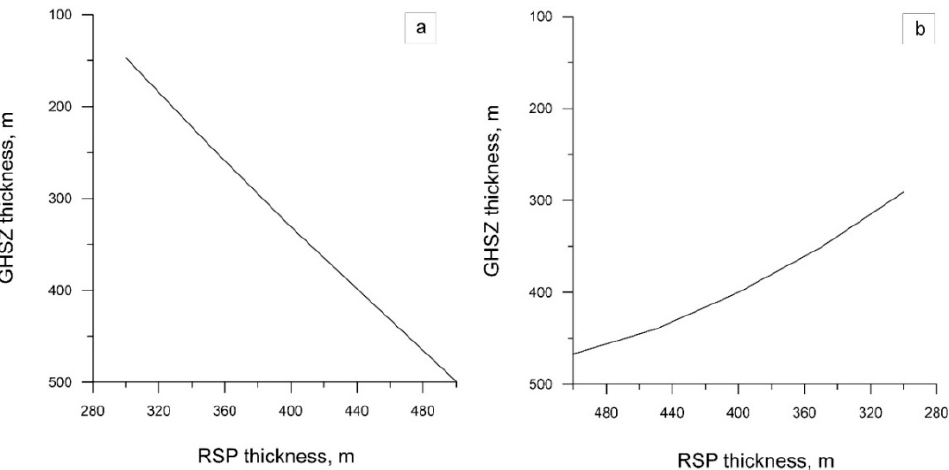
Figure 7. GHSZ versus RSP thicknesses during ( a ) subaerial and ( b ) subaquatic environments at an HF of 60 mW/m 2 .